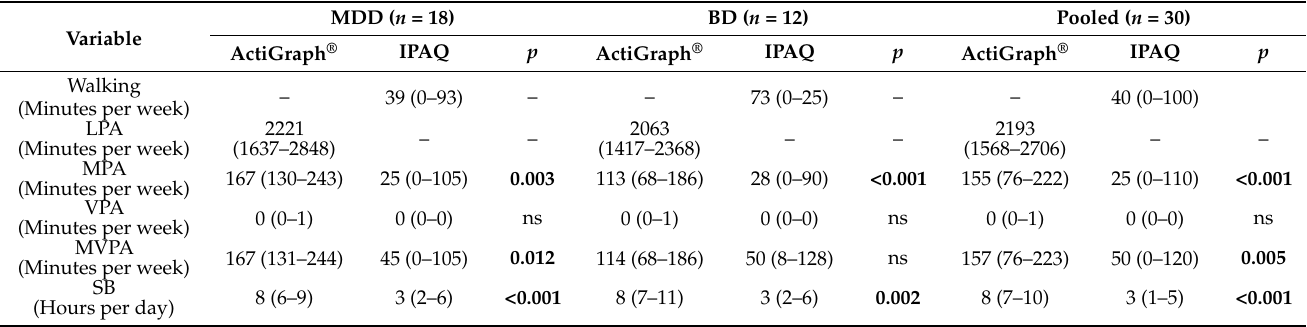
Table 2. Comparison (Mann–Whitney test) of the measurements obtained by IPAQ (walking,